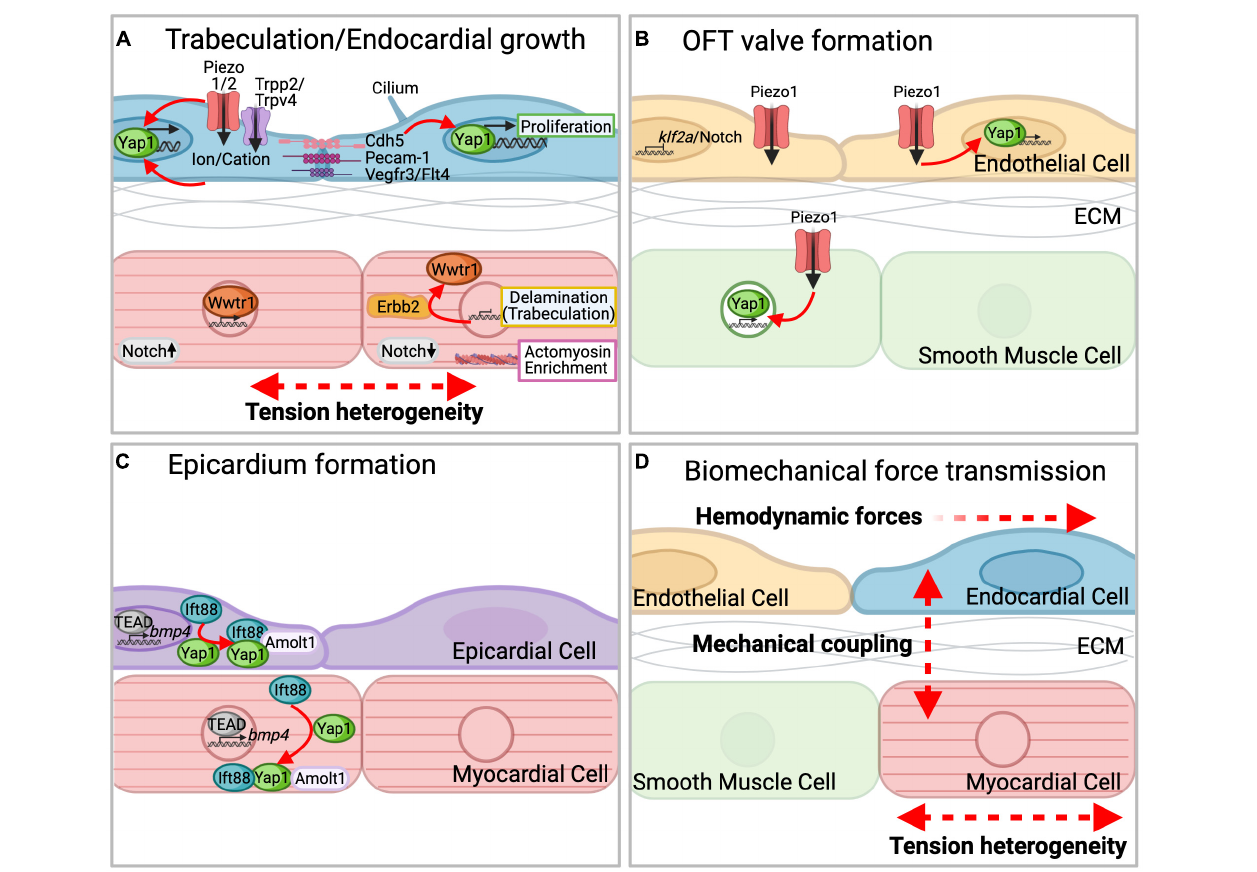
FIGURE 3 | Hippo signaling pathways during zebrafish cardiac development. (A) Cell junctional complexes (including Cadherin-5, Pecam-1, and Vegfr3/Flt4), stretch-induced ion channels Piezo1/2, or primary cilia act as mechanosensors within the endocardium (blue). Increased junctional forces within the endocardium are sensed by Cadherin-5, which triggers the nuclear localization of Yap1/Wwtr1 and causes endocardial cell proliferation. A compact wall architecture is organized within the myocardium (red). Tension heterogeneity upon myocardial proliferation induces actomyosin enrichment at their apical sides and causes the nuclear localization of Yap1. This triggers delamination of myocardial cells that seed the trabeculation layer. Neighboring myocardial cells activate Notch signaling, which inhibits actomyosin network contractility. Erbb2-mediated nuclear export of Wwtr1 causes myocardial cell lamination into the trabecular layer. (B) Within the outflow tract (OFT) valve, Piezo1 regulates Yap1 nuclear localization within the endothelial (yellow) and smooth muscle cell layers (green). Within the endothelial layer, Piezo1 modulates expression of the mechanosensitive transcription factor klf2a . (C) During epicardial formation, Ift88 interacts with Yap1 within the cytoplasm and forms a complex with Amolt1 to regulate Yap1 activity. Within the nucleus a Yap1-Tead complex activates expression of bmp4 , which restricts the growth of proepicardium (purple) and myocardium (red). (D) Biomechanical forces involve hemodynamics, biomechanical coupling, and tension heterogeneity acting within different tissue layers. These mechanical stimuli activate mechanosensitive Hippo pathway